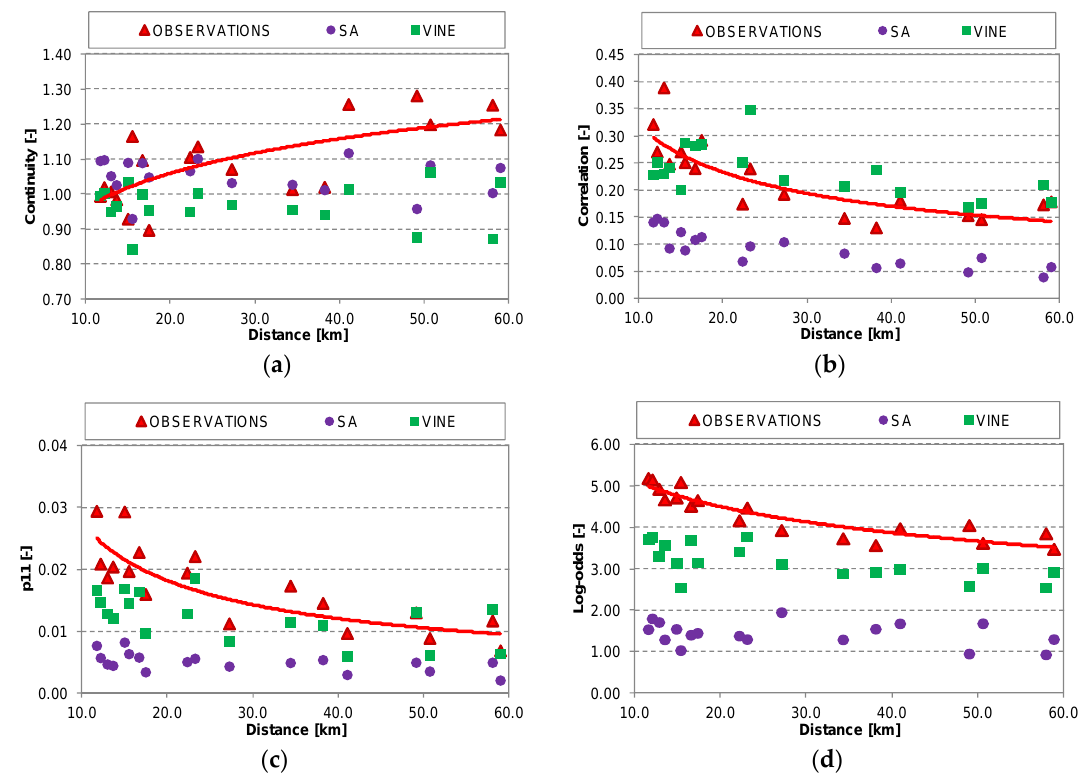
Figure 8. Bivariate spatial consistency measures of observed and simulated time series, small events are excluded: ( a ) Continuity measure; ( b ) Pearson’s coefficient of correlation; ( c ) Joint probability of rain in both stations; ( d ) Log-odds ratio.